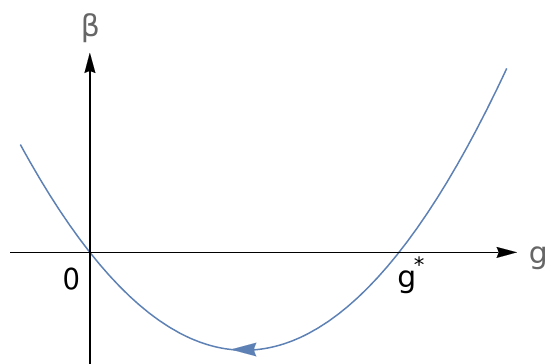
and the arrow points from ( N +8) ! 2 d